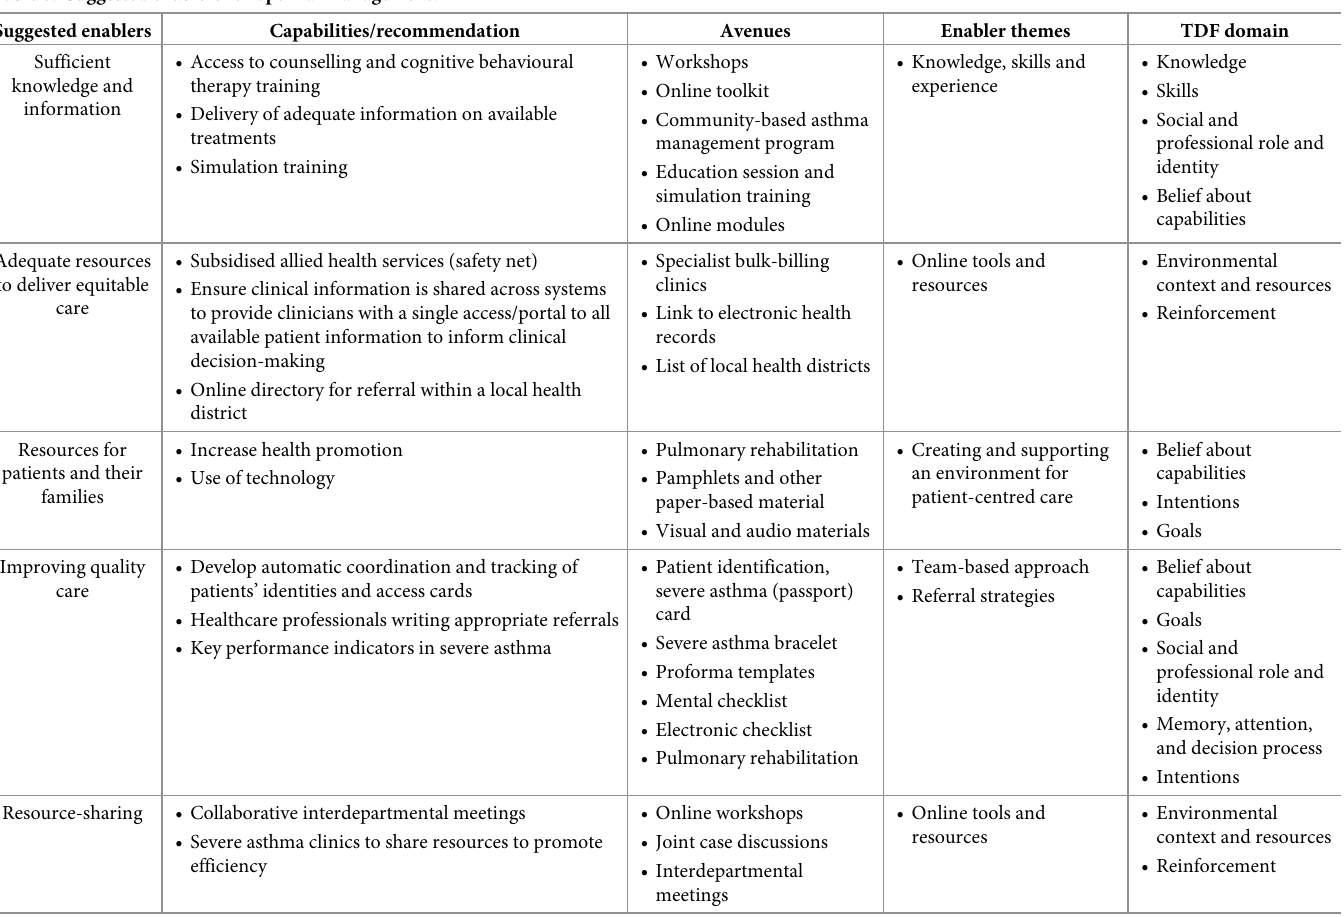
Table 6. Suggested enablers for optimal